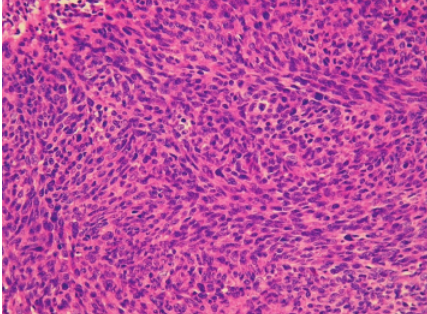
Figure 1: Hematoxylin-eosin staining, 100x, storiform, cellular organized tumor on periphery normal thyroid.